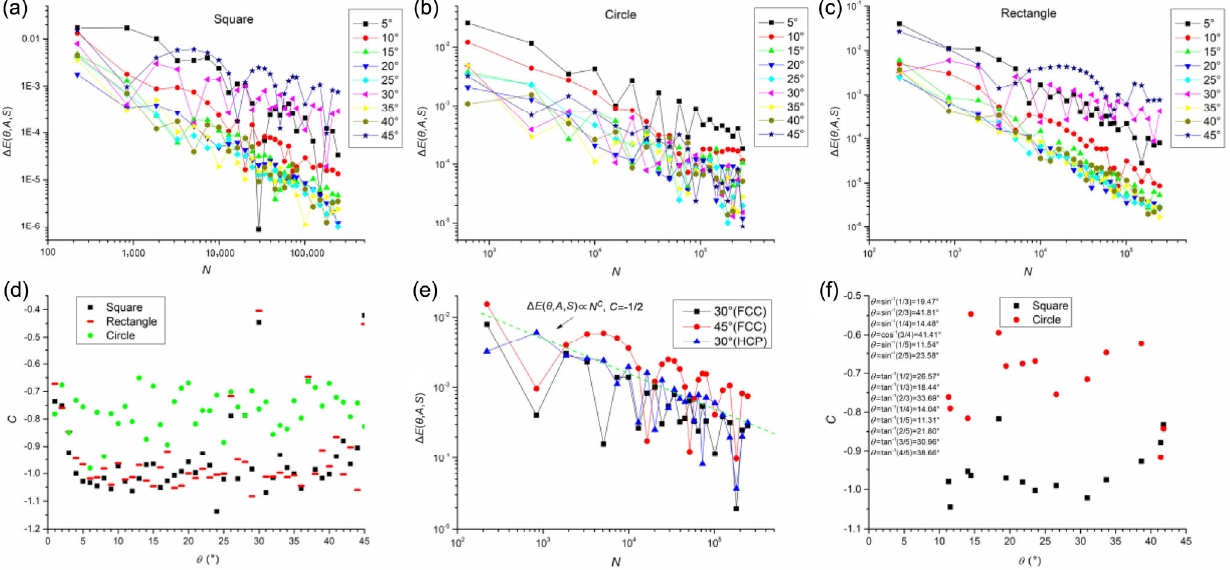
Fig. 6 Δ E ( θ , A , S ) of incommensurate systems with FCC lattice. (a–c) are double logarithmic plots between Δ E ( θ , A , S ) and N with different misfit angles and shapes. Clearly, there are Δ E ( θ , A , S )  N C in all cases. (d) shows the distribution of the exponent C . In most cases, C is around –1 for regular shapes (square and rectangle) and C is around –0.75 for irregular shapes (circle). In very few cases of regular shapes, C is around –0.5. (e) shows double logarithmic plots between Δ E ( θ , A , S ) and N in three specific cases ( θ = 30°/45° in FCC lattice and θ = 30° in HCP lattice) with C ≈ –1/2. (f) shows the distribution of the exponent C when any one of sin θ , cos θ , and tan θ is rational. Clearly, the expected cases of C = –1/2 for regular shapes or C = –1/4 for irregular shapes do not